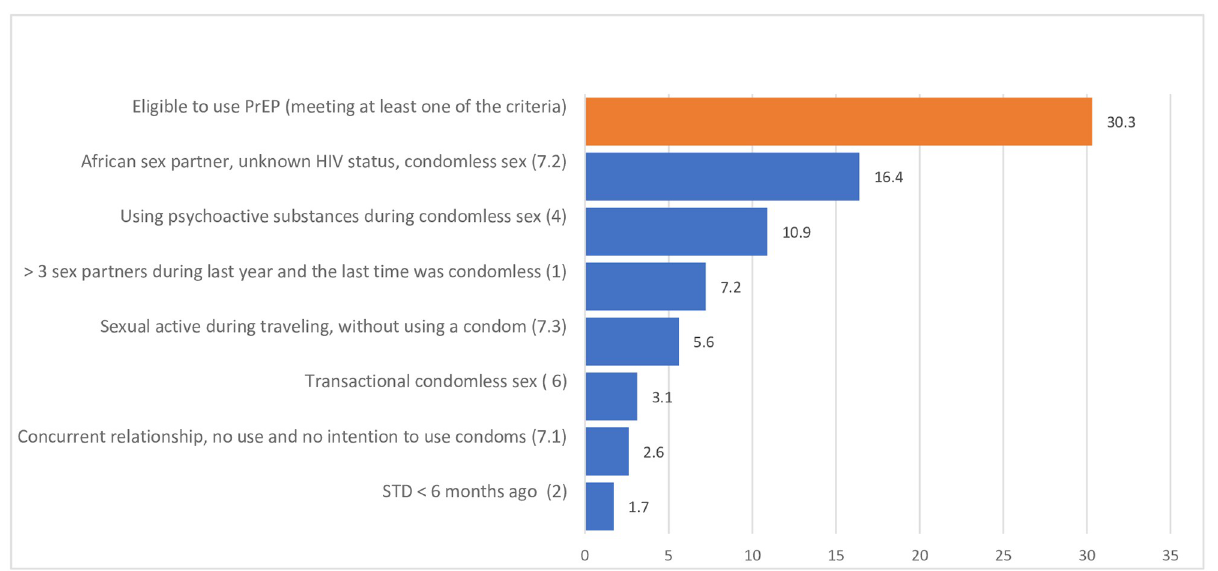
Fig 3. Graph 3: Percentages of SSA migrants meeting the PrEP eligibility criteria � . � as presented in Box 2 (Fig 2) See also the corresponding S1 Table.